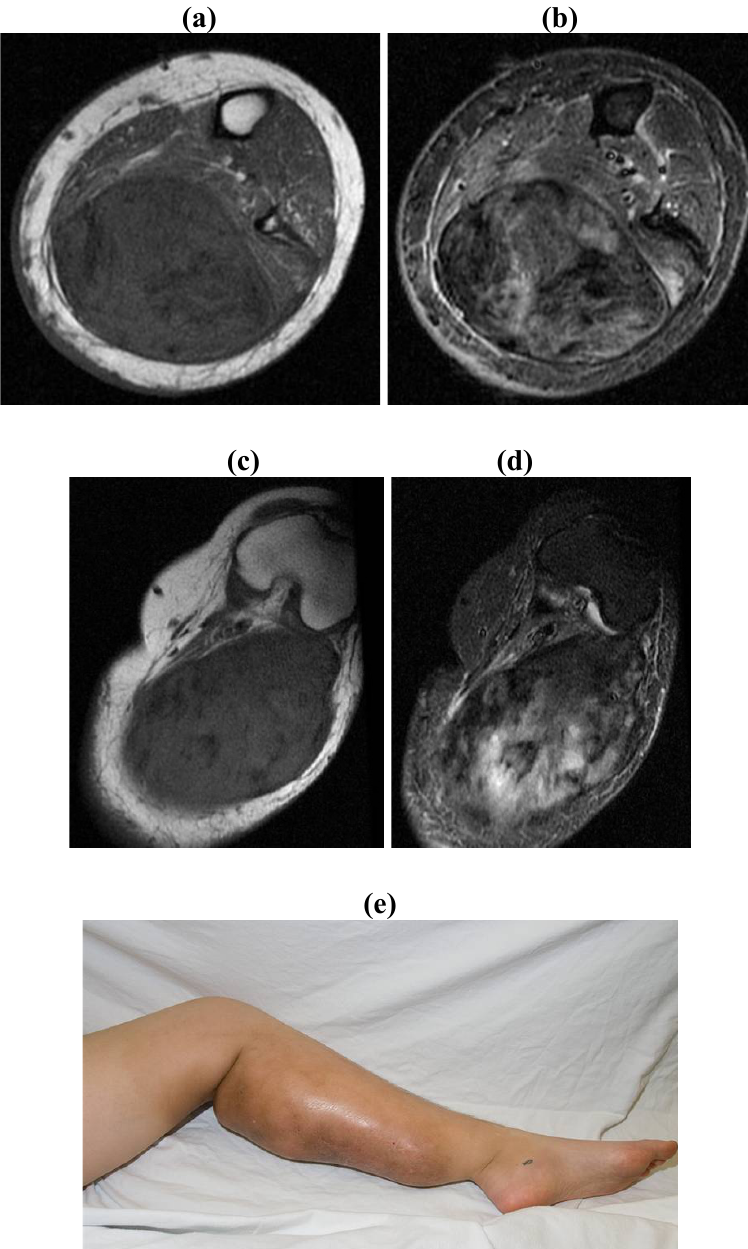
Figure 5. 23/F with a four year history of failed non-operative treatment of unresectable symptomatic desmoid tumor involving the left lower extremity. Patient had continued to progress despite 6000cGy of radiation and chemotherapy. Patient had 15 degrees of knee flexion contracture and 20 degrees of ankle flexion contracture in the setting of a painful leg. Patient was treated with an above knee amputation. MRI Findings: A huge heterogeneous mass is seen in the posterior compartment of the left thigh, extending superiorly above the knee joint within the biceps femoris and measuring 8 × 10.7 cm The popliteal vessels and tibial nerve are displaced due to the enlarging mass and abnormal T2 signal extends from the mass to these displaced neurovascular structures which could represent peritumoral edema or microscopic infiltration. There is encasement of the common fibular nerve in addition. (a) Axial T1 at level of leg; (b) Axial T2 at level of